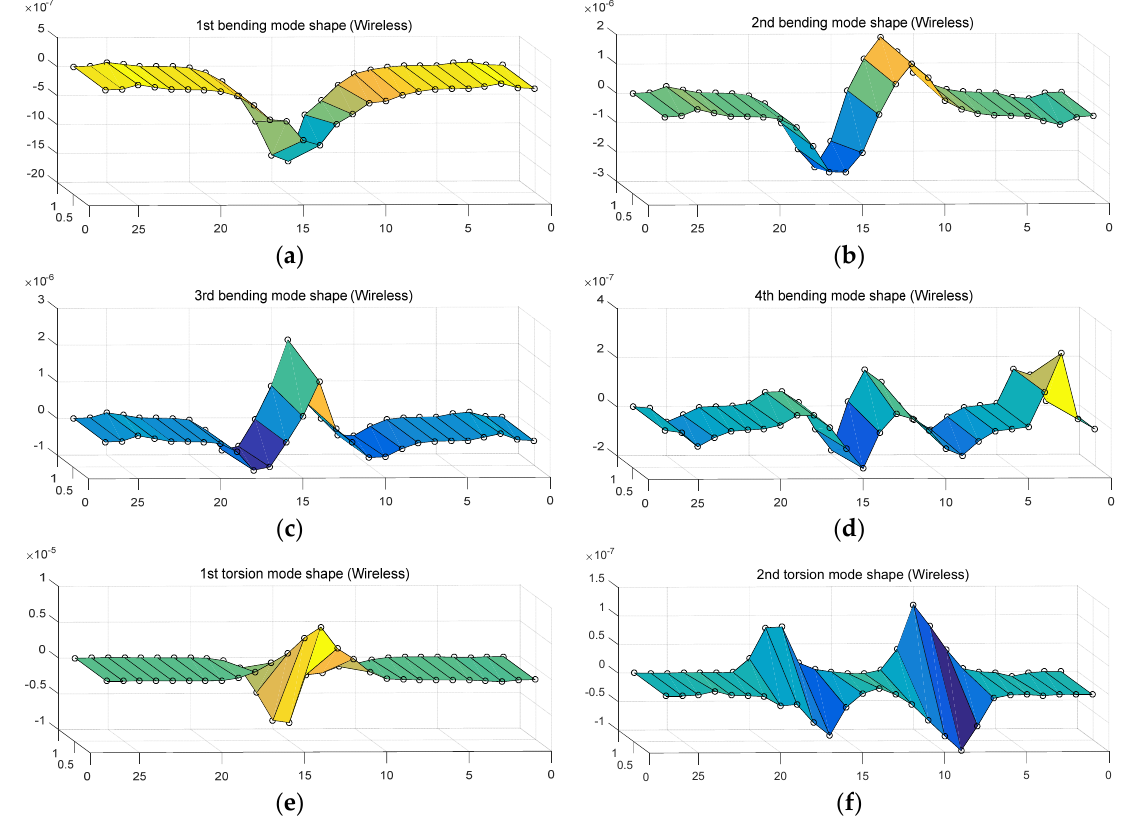
Figure 12. Wireless mode shape: ( a ) 1st bending mode; ( b ) 2nd bending mode; ( c ) 3rd bending mode; ( d ) 4th bending mode; ( e ) 1st torsion mode; ( f ) 2nd torsion mode. Table 4 states modal correlation on six objective modes calculated using Equation (1) in MAC.